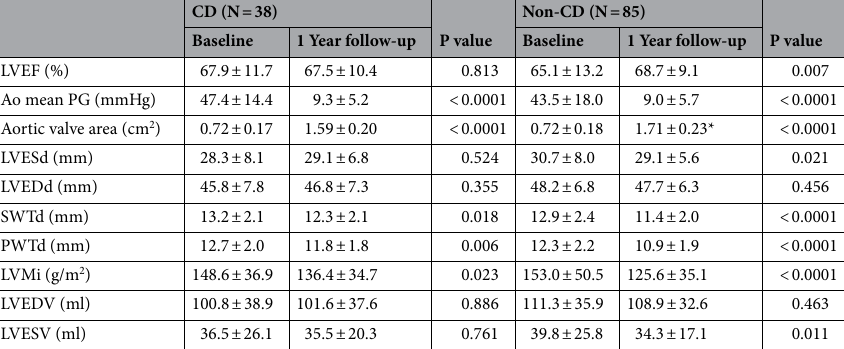
Table 3. Baseline and 1-year postprocedural echocardiographic parameters according to CD in patients complete 1-years follow-up. Mean ± SD are shown. CD conduction disturbance, LVEF left ventricular ejection fraction, LVESd left ventricular end-systolic dimension, LVEDd left ventricular end-diastolic dimension, PWTd posterior wall thickness at end diastole, SWTd septal wall thickness at end diastole, LVMi left ventricular mass index, LVEDV left ventricular end-diastolic volume, LVESV left ventricular end-systolic volume. *P < 0.05 as compared to 1 year data in CD group.